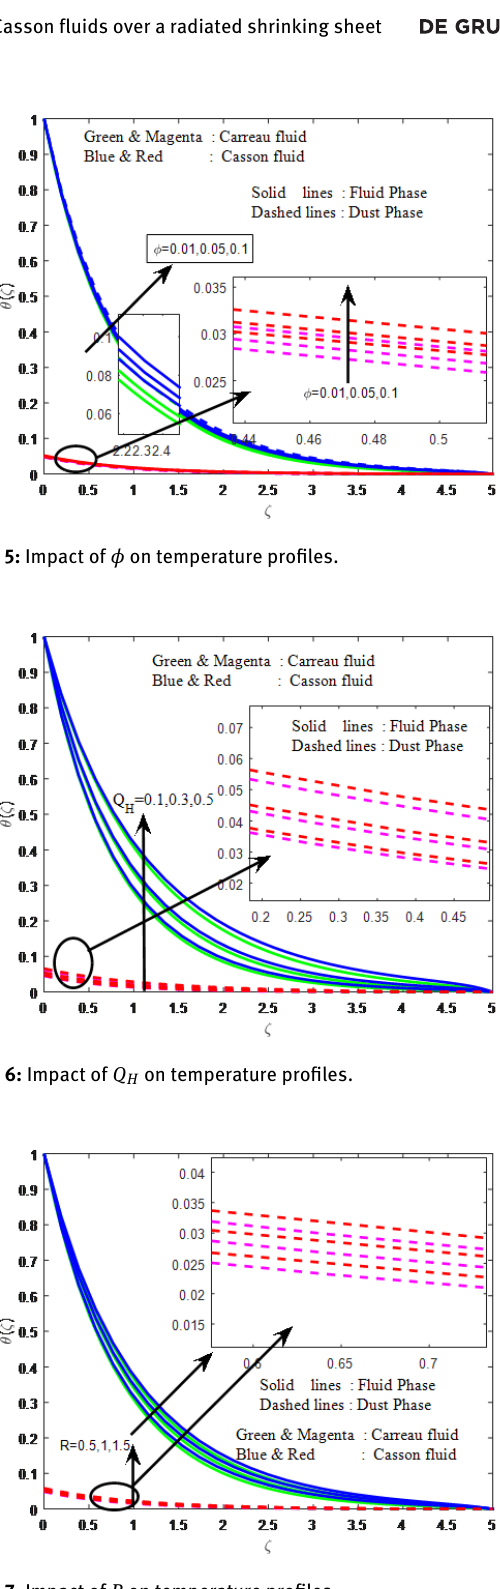
Fig. 7: Impact of R on temperature